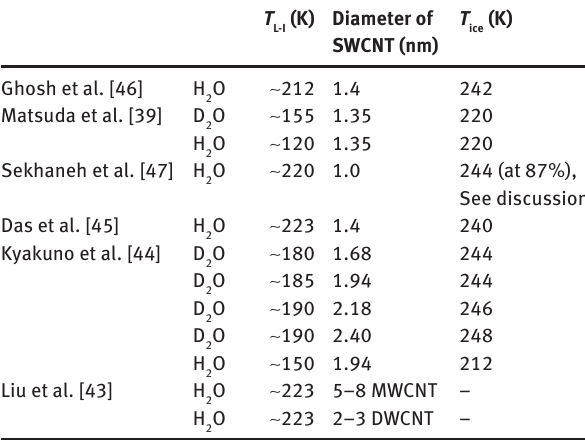
Table 1: The reported temperatures of the liquid-ice transition, T inside CNTs, in the NMR time scales.